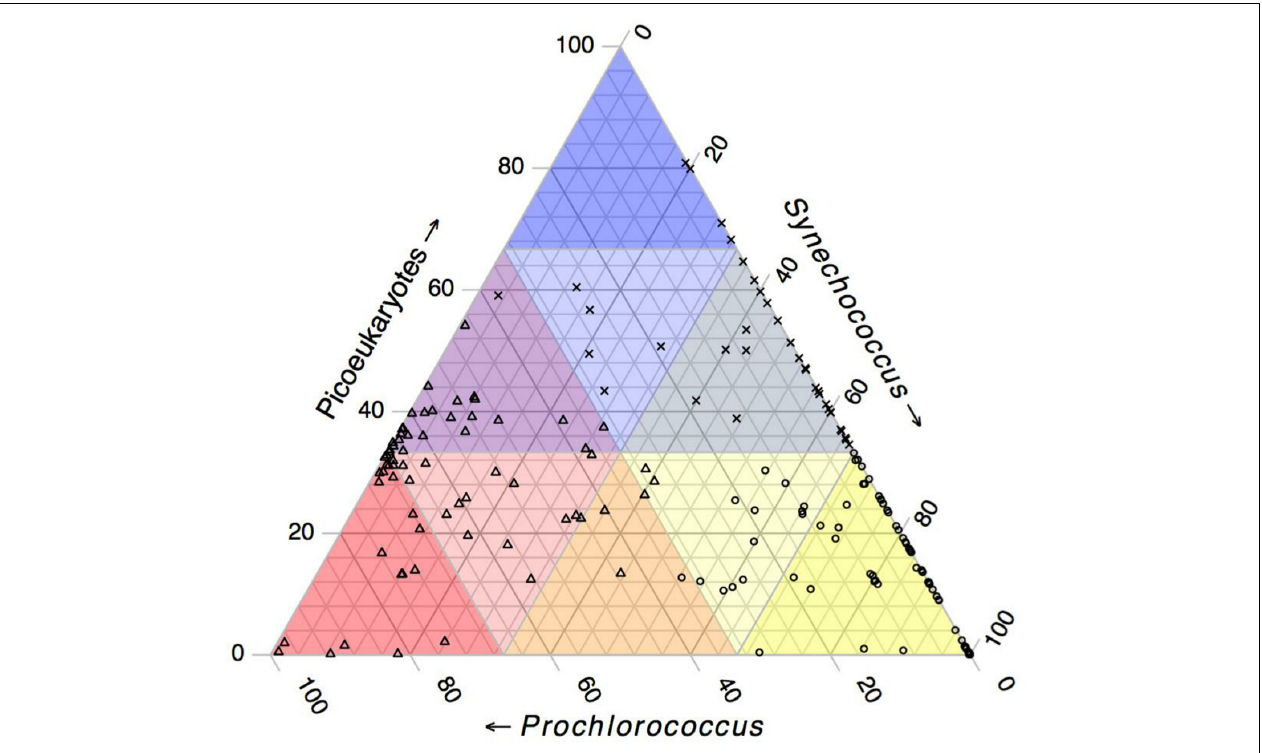
FIGURE 6 | Ternary plot showing the biovolume proportions of the three picophytoplankton groups. The triangular regions at the corners represents the biovolume proportions > 66% for picoeukaryotes (darkest blue), Synechococcus (darkest yellow), and Prochlorococcus (darkest red). The intermediate-colored areas correspond to biovolume proportions between 33 and 66% (intermediate light colors), and the regions opposite each corner represent 0–33% for the corresponding group. Different symbols represent the three k-means clusters, where circles correspond to cluster A, for the highest average biovolume proportions for Synechococcus ( p < 0.05, 80.2 ± 1.6%) and the lowest for picoeukaryotes ( p < 0.05, 14.2 ± 1.2%); triangles correspond to cluster B, for the highest average Prochlorococcus -biovolume proportion ( p < 0.05, 60.3 ± 1.4%) and the lowest for Synechococcus ( p < 0.05, 11.7 ± 1.7%); and crosses correspond to cluster C, for the highest picoeukaryote proportions of the three clusters ( p < 0.05, 50.5 ±